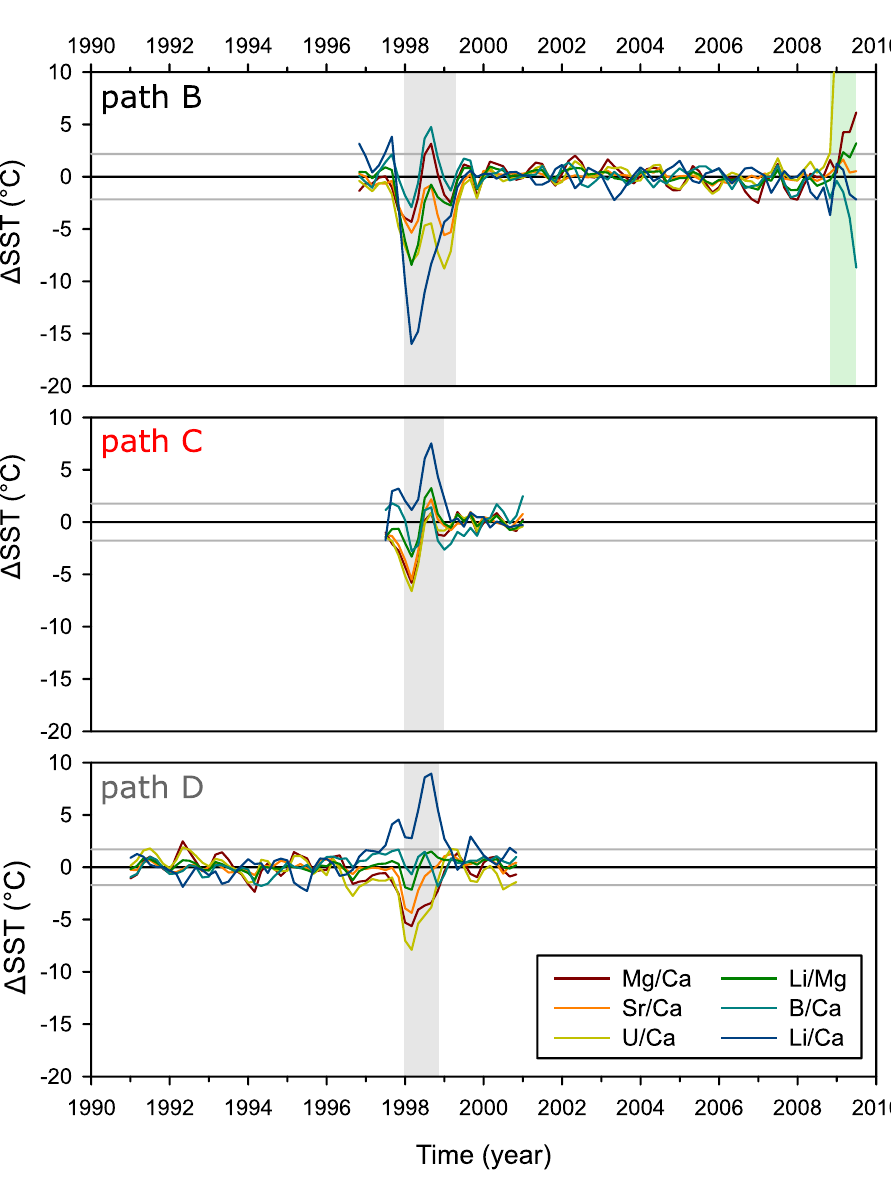
Figure 4. Difference between the bimonthly (interpolated) records of measured SST and TE-seawater temperature reconstruction for three different sample paths (see Fig. 2). The period covered by the tissue layer is highlighted in green while the period affected by the 1998 thermal stress event is highlighted in grey. The horizontal grey lines indicate the average 2 SD for all elements, this is approximate a 2 °C